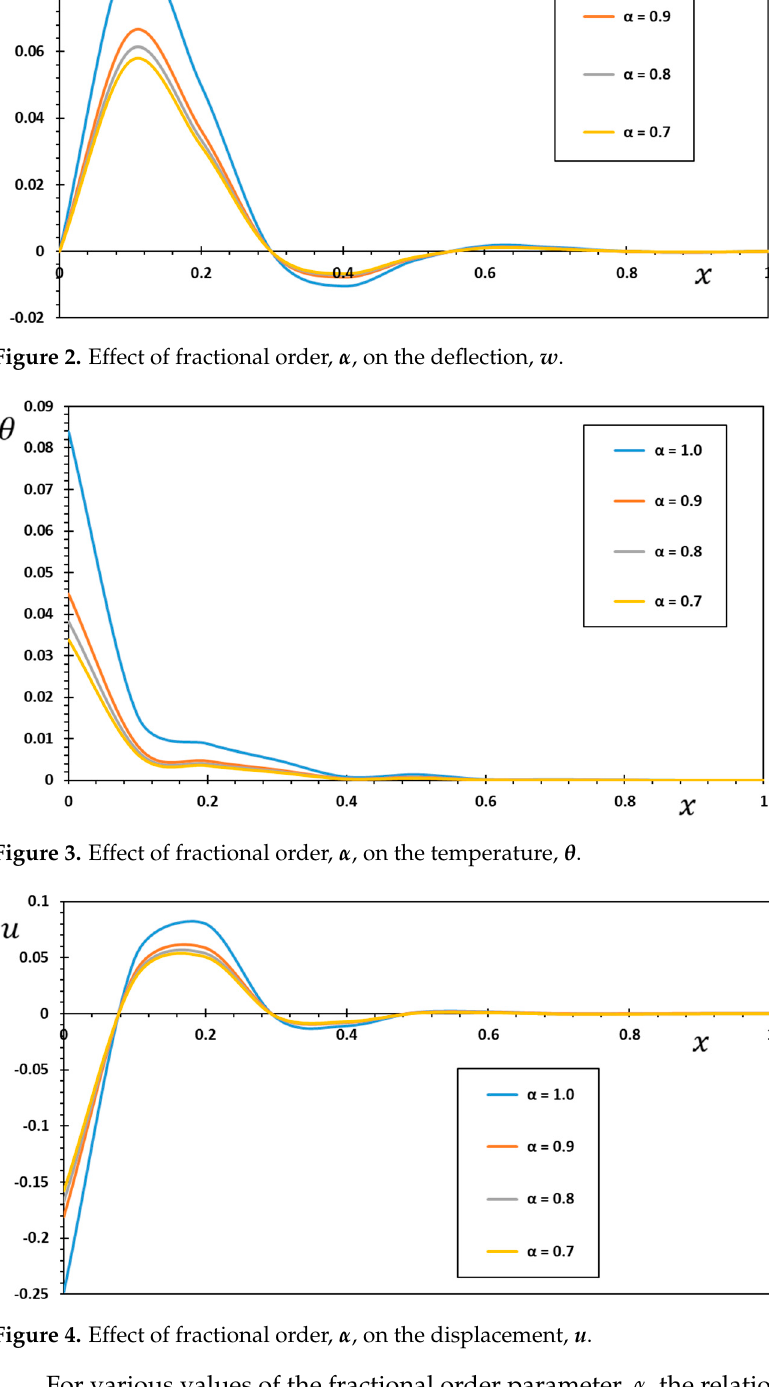
Figure 4. Effect of fractional order, 𝜶 , on the displacement, 𝒖 . In Figure 5, we see how the fractional parameter affects the relationship between the thermal bending moment, 𝑀 , and the distance, 𝑥 . This image shows how the modulus can affect the bending moment of the nanobeam, 𝑀 . It has also been shown that the peak bending moment grows under all conditions as the fractional parameter grows. The bend- ing moments, 𝑀 , calculated using the fractional derivative are offered as more minor in